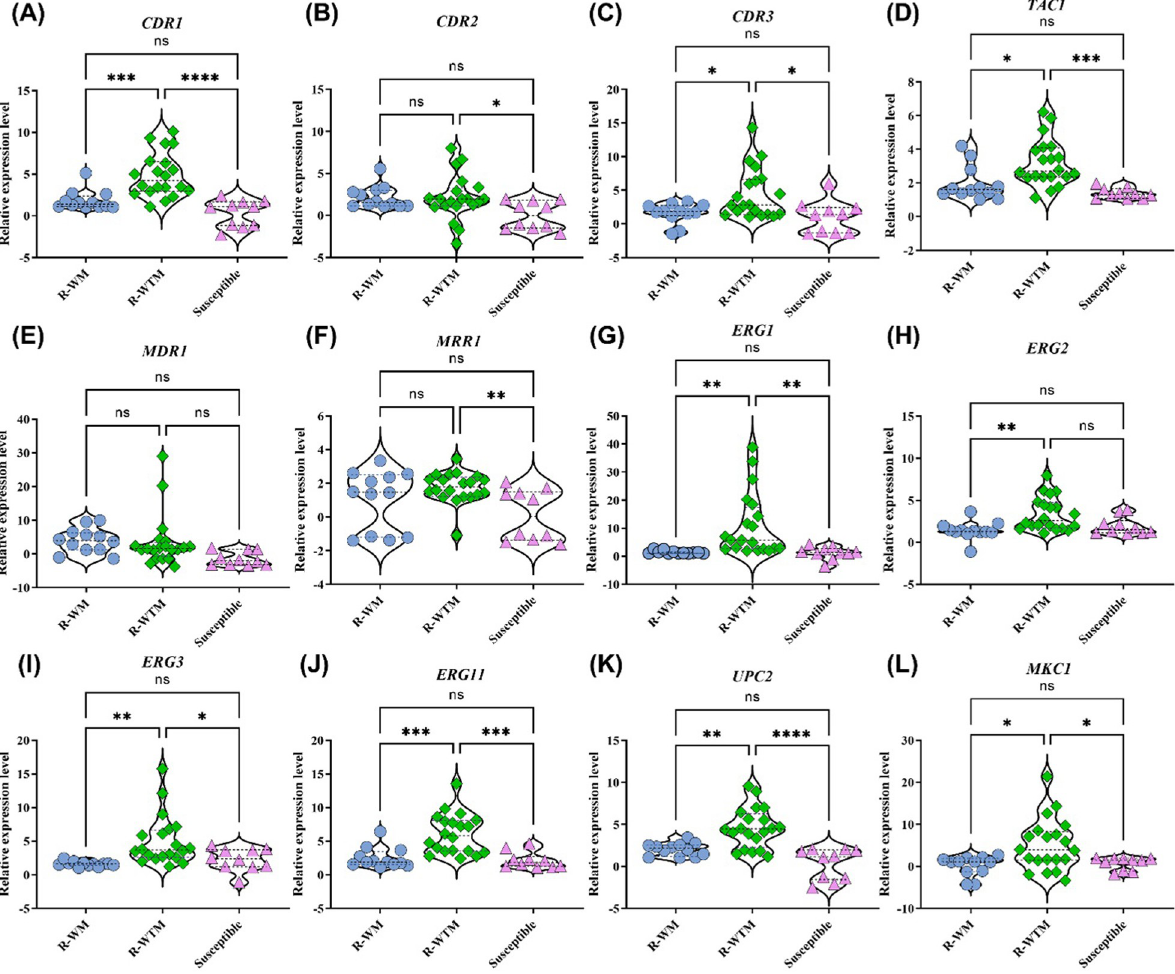
Fig 1. Scatter dot plots depicting the inducible expression of different transporters ( CDR1 , CDR2 , CDR3 and MDR1 ), ergosterol biosynthesis pathway genes ( ERG1 , ERG2 , ERG3 , ERG11 , and ERG24 ), and transcription factors ( TAC1 , MRR1 and UPC2 ) represented as fold change relative to untreated control. The level of expression was calculated using 2 - ΔΔ CT method. One-way ANOVA with multiple comparisons was perform to determine the statistical significance. � p < 0.05, �� p < 0.01, ��� p < 0.001, ���� p < 0.0001, and NS = Non Significant.